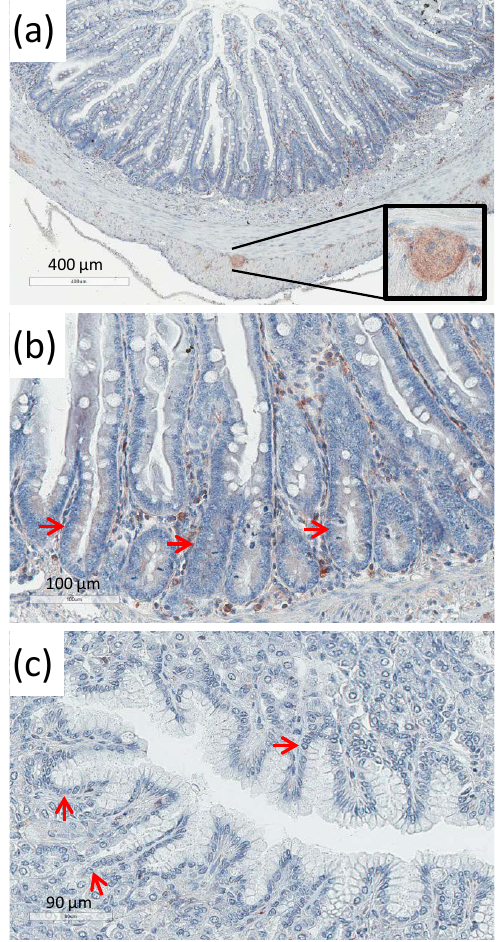
Figure 5. Immunohistochemical detection of c-CBL in the mar- moset gut and stomach. (a) Low-power magnification showing a cross section of the gut. While the cells in the basal part of the crypts are not stained, the ganglia between the two peripheral muscle lay- ers were stained (see inset). (b) Higher magnification of the central part of (a) . The sites where the stem cells are located in the crypt are labeled with red arrows. No c-CBL staining was visible. (c) Sec- tion of the adult stomach. No staining was visible in the glands at the sites where the endodermal epithelial stem cells are located (red arrows).